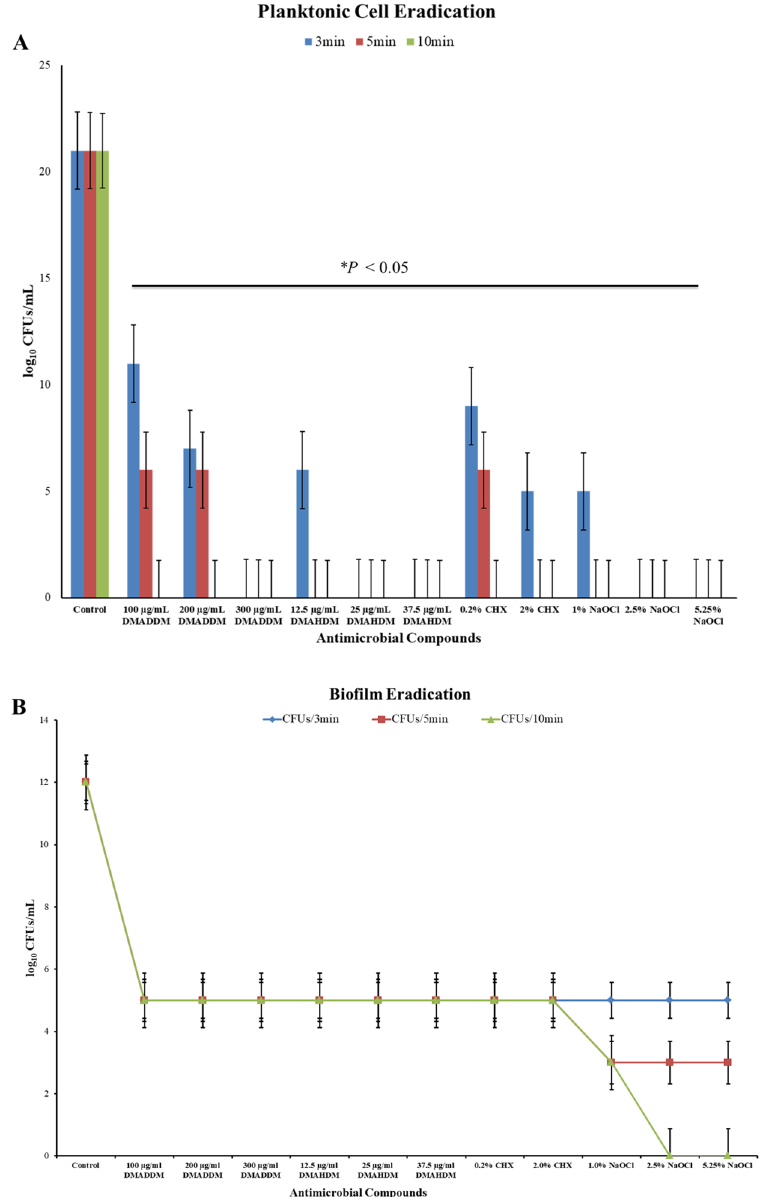
Figure 1. ( A ) Planktonic bacteria eradication analysis by DMADDM, DMAHDM, CHX and NaOCl at different concentrations for 3 min, 5 min and 10 min. Each value is mean ± standard deviation (n = 9) * P < 0.05. ( B ) log CFUs of bacteria after treatment with different concentrations of DMADDM, DMAHDM, CHX and NaOCl for 3 min, 5 min and 10 min. Each value is mean ± standard